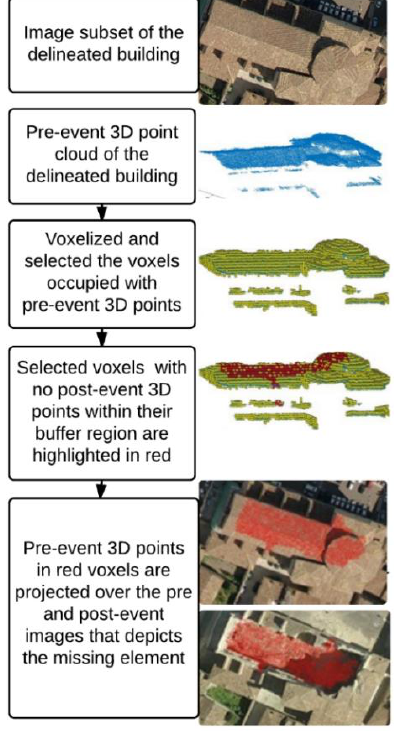
Figure 2. Workflow of voxel-based approach